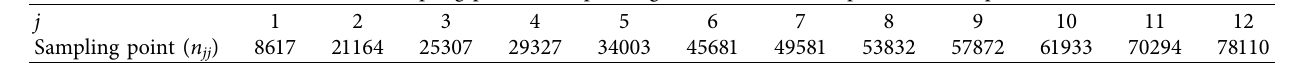
Figure 19: Engine knocking signal. Table 7: The sampling point corresponding to the fault feature points of each period.